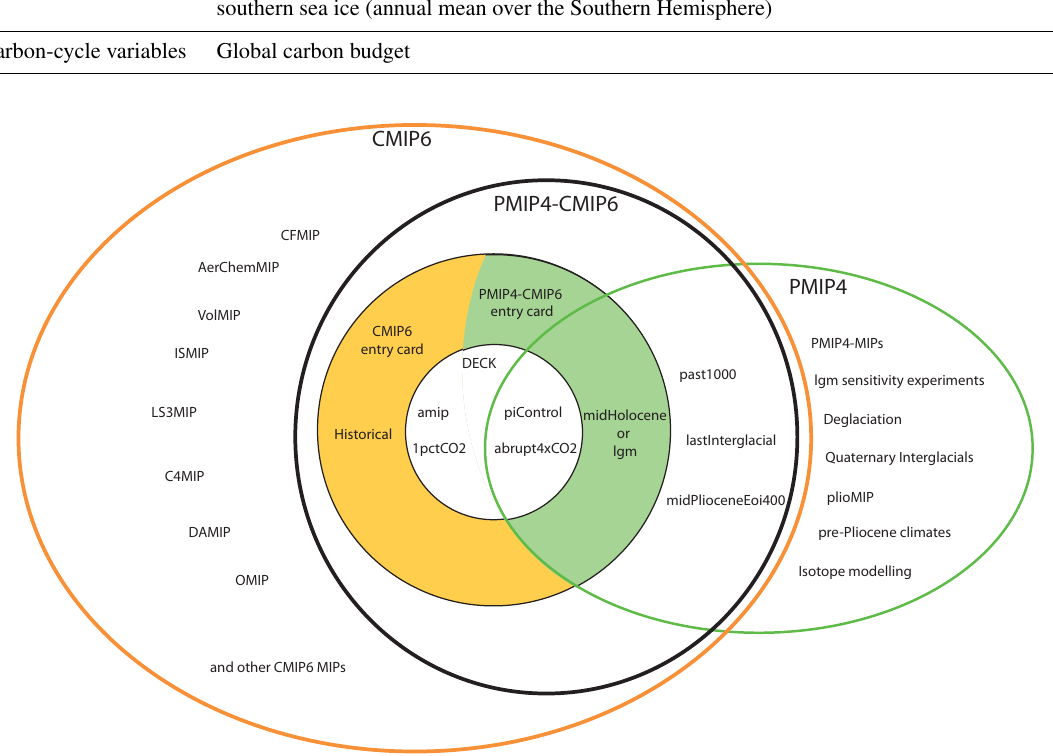
Figure 4. The PMIP4-CMIP6 experiments in the framework of CMIP6 (a) , with associated MIPs; and in the framework of PMIP4, with its working groups (b)